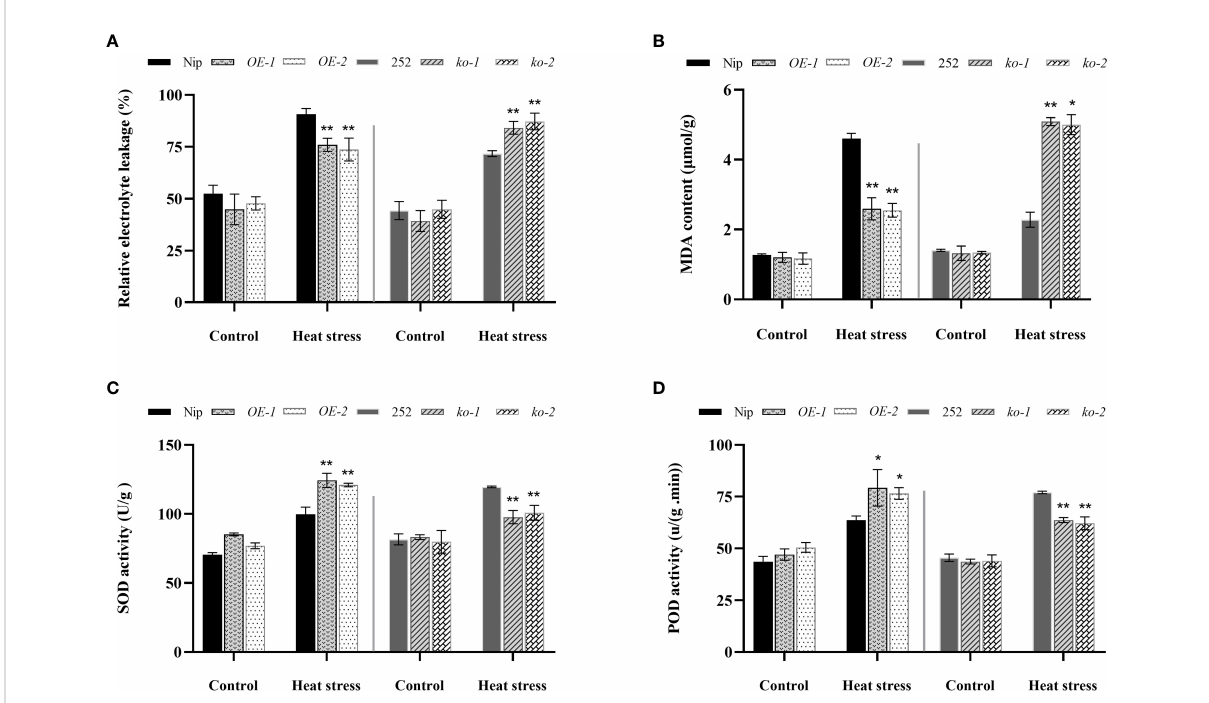
FIGURE 3 Changes in membrane lipid peroxidation and antioxidant enzyme activities in the transgenic lines and WT plants under heat stress. The electrolyte leakage rate (A) and MDA content (B) and SOD activity (C) and POD activity (D) in transgenic lines and WT after 48 h heat stress. Data are means ± SD (n = 3; *P < 0.05, **P < 0.01, Student ’ s t